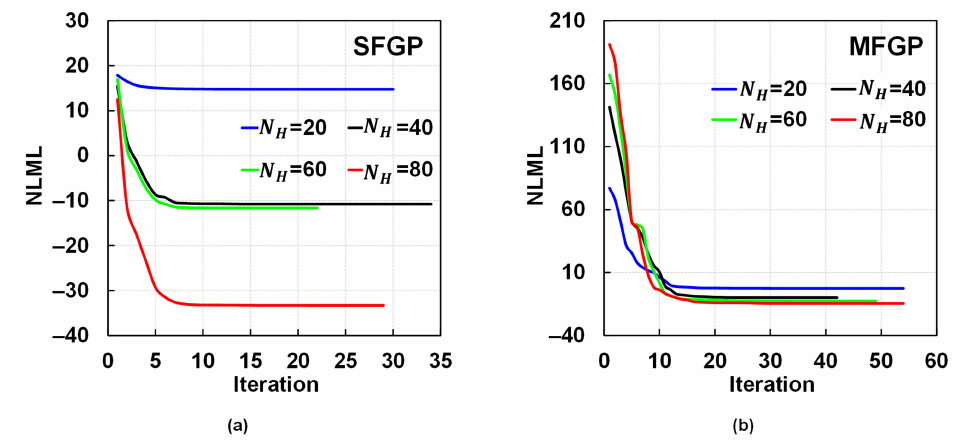
Figure 13. Comparison of convergence of NLML: ( a ) SFGP for 20, 40, 60, and 80 HF points and ( b ) MFGP for 20, 40, 60, and 80 HF points integrated with 80 LF